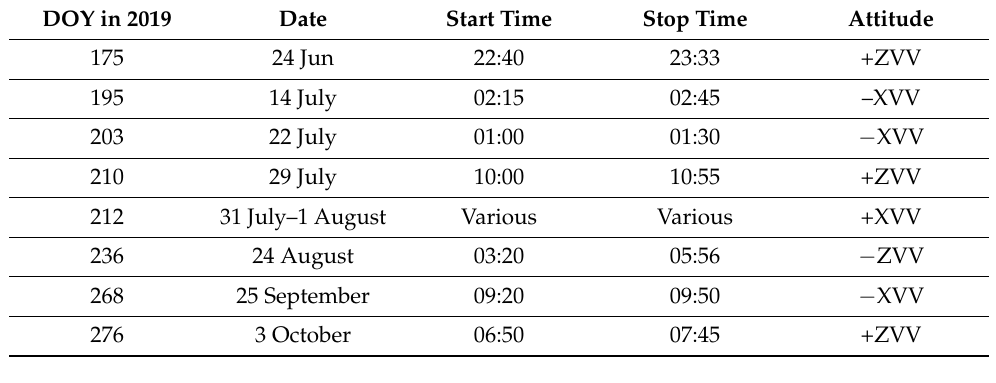
Table A1. ISS pitch-up/down days used by CTI for deep-space calibration.